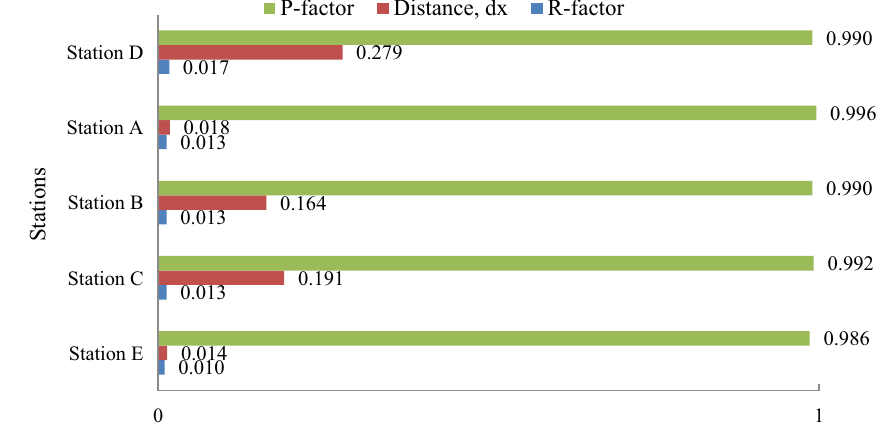
Fig. 8 Summary of SUFI-2 results for hybrid BA-ANN model in all five study areas